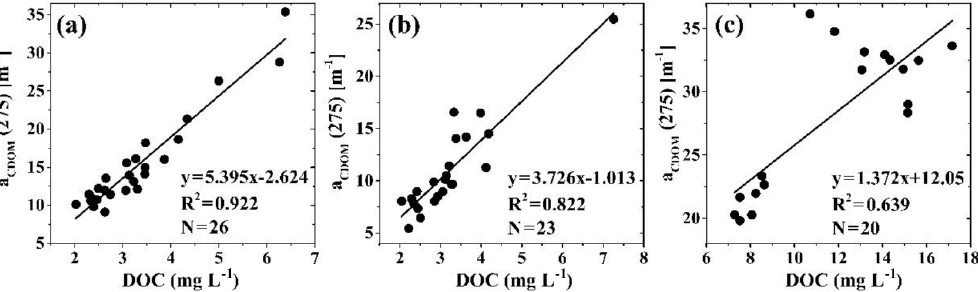
Figure 5. The relationships between a CDOM (275) and DOC at sections across (a) the Yalu River, (b) the Hunjiang River, and (c) the Songhua River. The samples were collected at each station at about 1 week or around 10 days apart in the ice-free season in 2015.